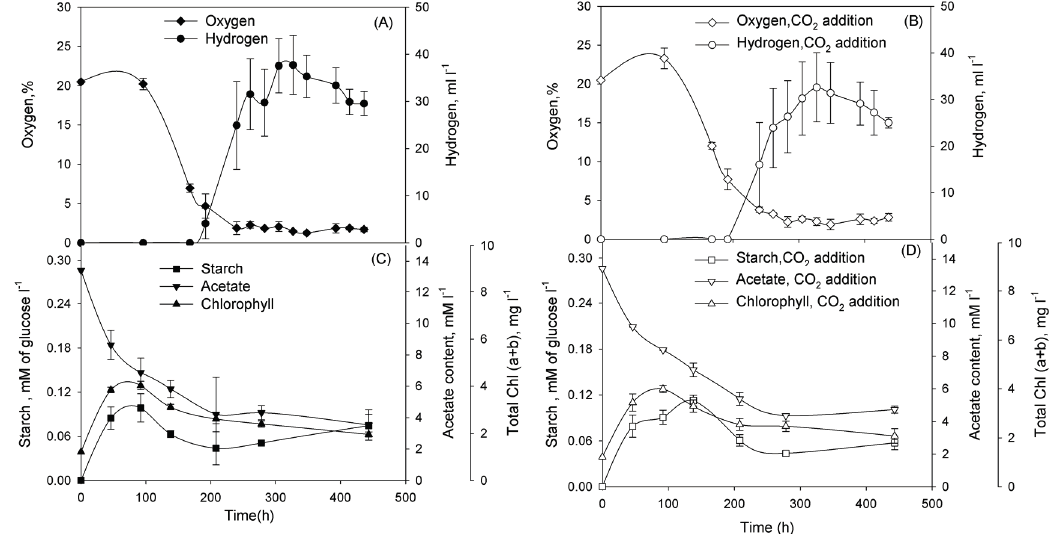
Figure 4. Incubation of Chlorella sp. in TA-P/SW medium without CO 2 ( A , C ), and with CO 2 additions ( B , D ). At the start of incubation the gas phase was supplemented with CO 2 to 10% ( v / v ). Parameters that were examined: ( A , B ) O 2 concentration in a gas phase of vials (%) and volume of the H 2 gas produced (mL·L − 1 of suspension); ( C , D ) intracellular starch and acetate in the medium (mM·L − 1 ), total (a + b) chlorophyll (mg·L − 1 ). Figure represents data of typical experiments from three independent repetitions with the same trend. For all graphs on Figure 4 simple error bars curves were